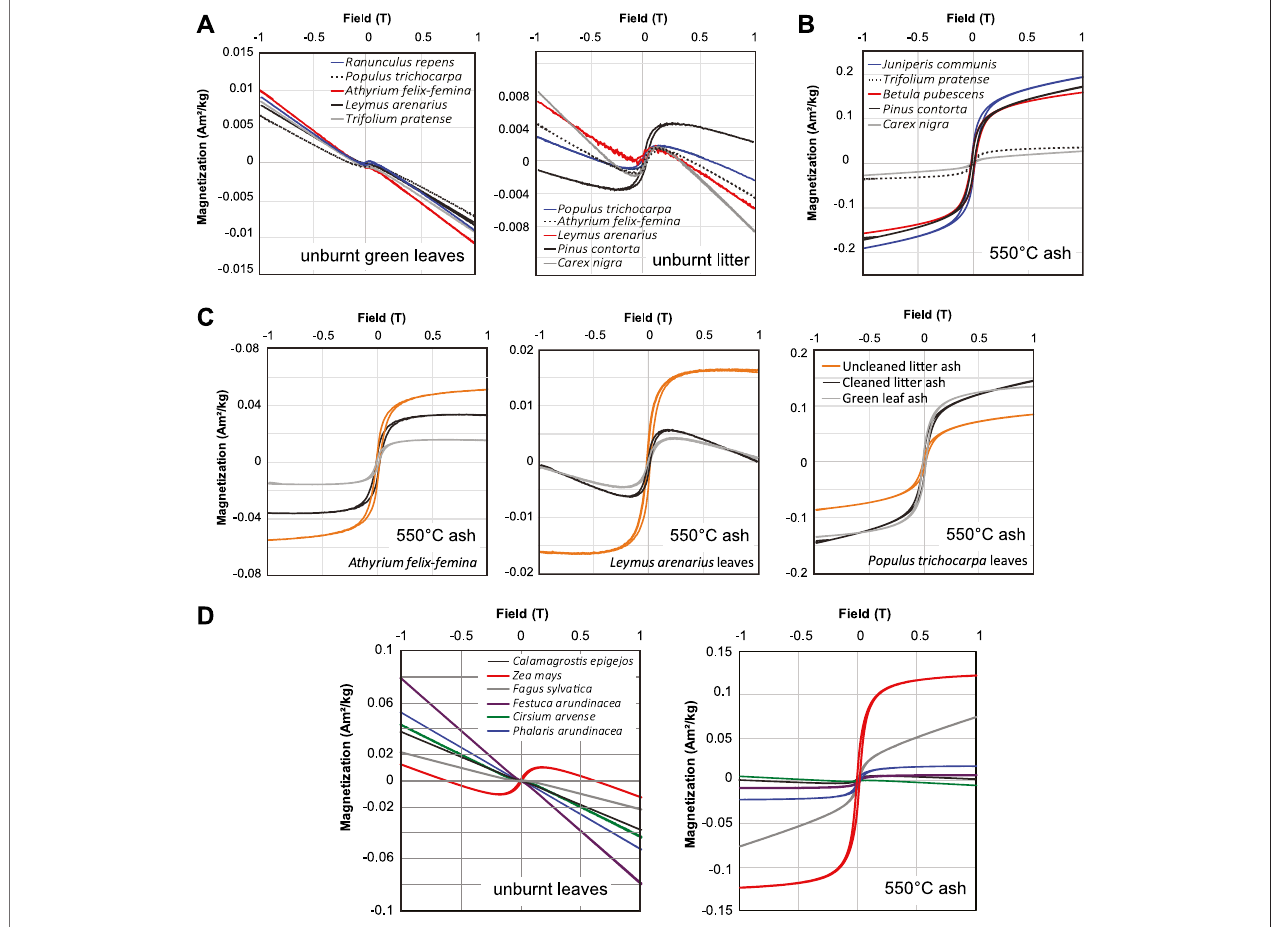
FIGURE 5 | Example hysteresis loops for (A) unburnt Icelandic plant samples, (B , C) ashed Icelandic plants, and (D) unburnt and ashed German plant samples.